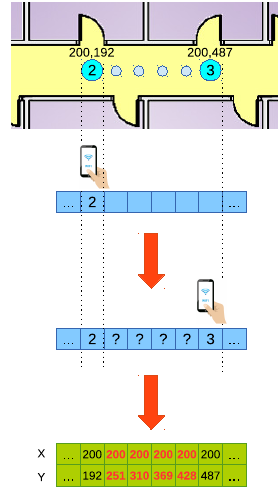
Figure 7. Groundtruth generation. Figure 7. Ground truth